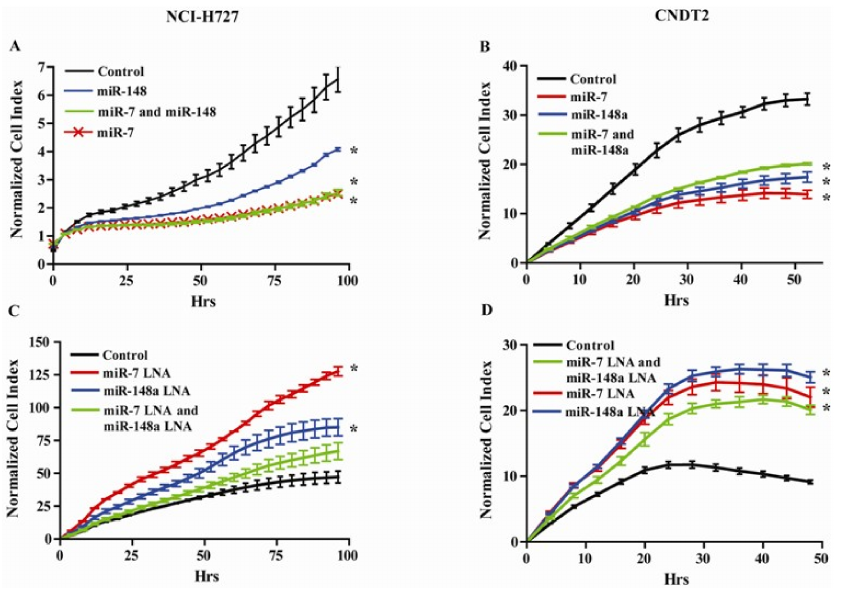
Figure 5. miR-7 and miR-148a regulates growth of the carcinoid cell lines NCI-H727 and CNDT2. ( A ) and ( B ) Both miR-7 and miR-148a reduces cellular growth of the carcinoid cell lines NCI-H727 and CNDT2 where the highest inhibitory effect is caused by transfecting with miR-7. ( C ) and ( D ) Inhibiting miR-7 and miR-148a by transfecting the carcinoid cell lines NCI-H727 and CNDT2 with miRNA inhibitors alleviate growth repression and cause the cells to grow more than the controls. * growth rates statistically significant compared to